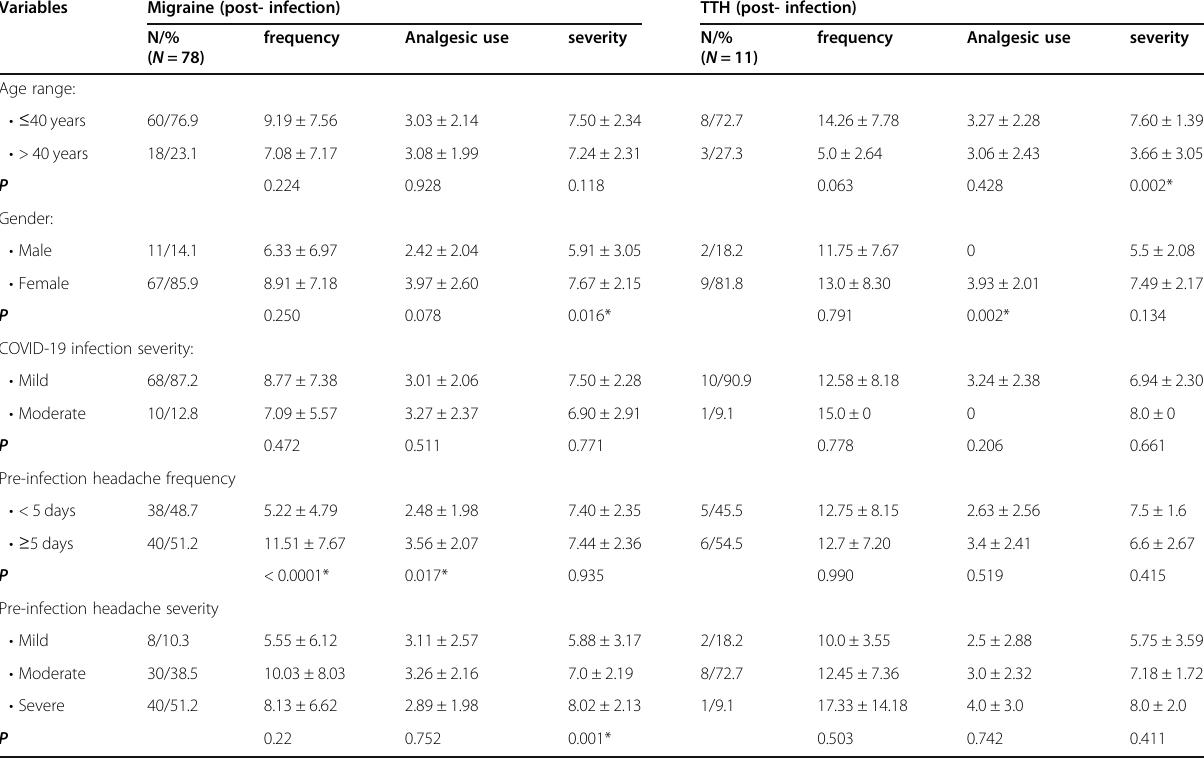
Table 4 Characteristics of Post COVID-19 headache changes in relation to age, gender COVID-19 severity and baseline Headache frequency and severity